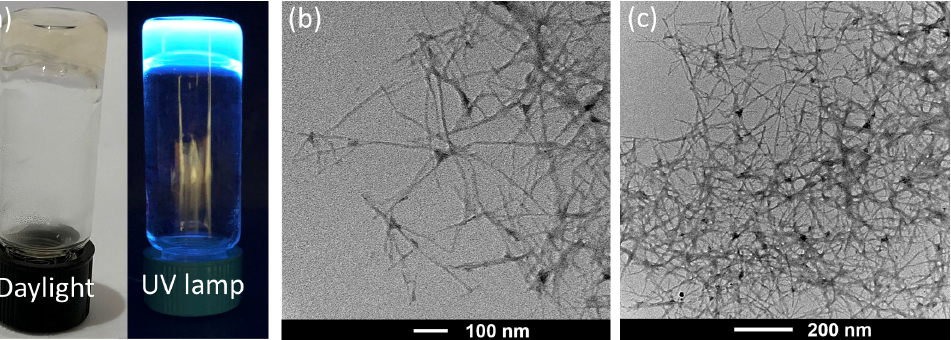
Figure 1. ( a ) Photograph of the gel under daylight and UV lamp; gel formation was assessed by the vial inversion test. ( b , c ) TEM micrographs of the